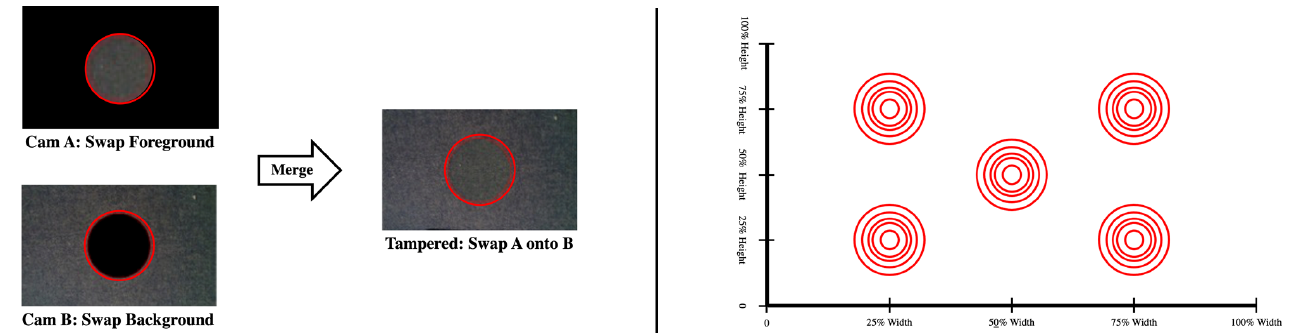
Figure 5. Image blob-swap methodology example with blob-swap locations. Blobs are randomly exchanged across images to evaluate the tampering score sensitivity to size and position. Swaps are performed in the image center, top left quadrant, top right quadrant, bottom left quadrant and bottom right quadrant. Swap size is varied by taking radii from 1 th image width to 1 th image width. These locations are indicated in Figure 5. For 12 50 reference, this translates to a worst-case radius range of 9 to 40 pixels at the sixteenth down-sample